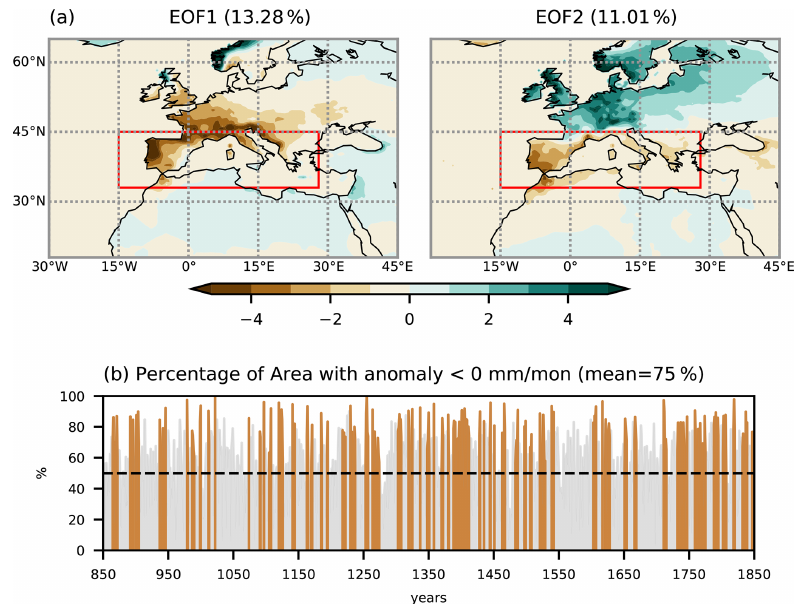
Figure 1. (a) Variance explained by the first EOF and second EOF in the observed monthly precipitation from the U.Delaware v5.01 dataset for the period of 1901–2000CE. The red rectangle indicates the region of study: western and central Mediterranean. (b) Percentage of area with the soil moisture anomaly below 0mm per month in the region of study during the last millennium in CESM. Brown shading indicates the years with